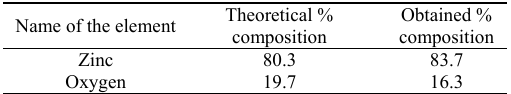
Table 1. Elemental composition of the synthesized ZnO (EDS) Fig. 1. (a) X- ray diffraction pattern, (b) FTIR spectrum of the synthesized ZnO nanoparticles Name of the element